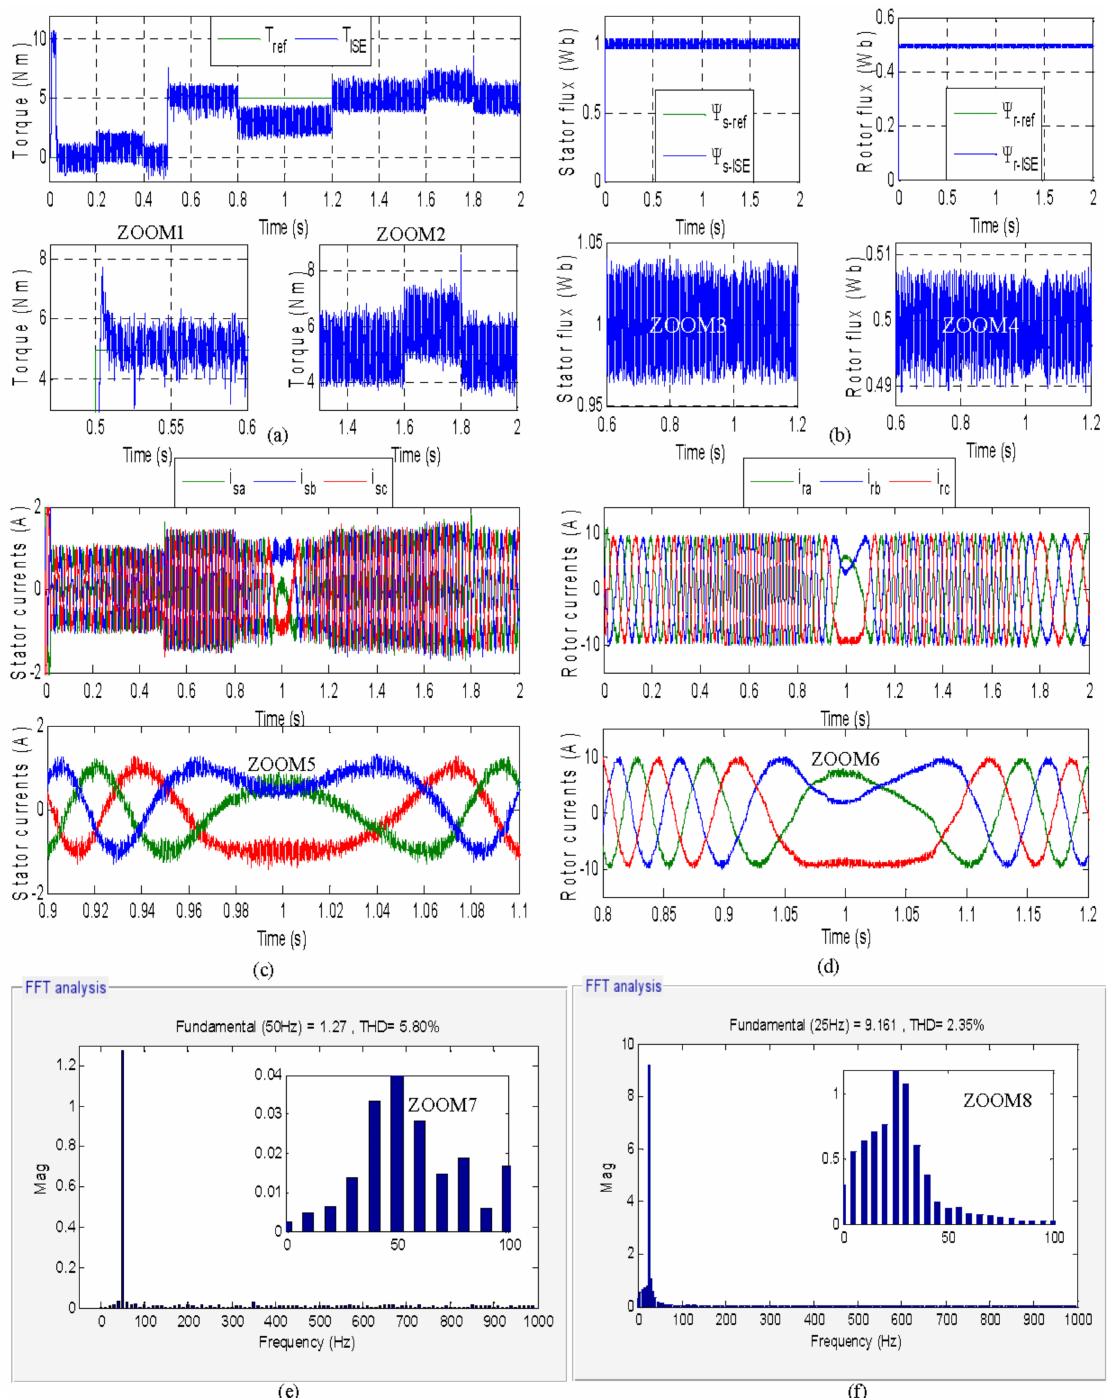
Figure 9. GA-DTC-ISE performances. ( a ) The electromagnetic torque response. ( b ) The fluxes response. ( c , d ) The stator and rotor currents. ( e , f ) Harmonic spectra of the stator and rotor